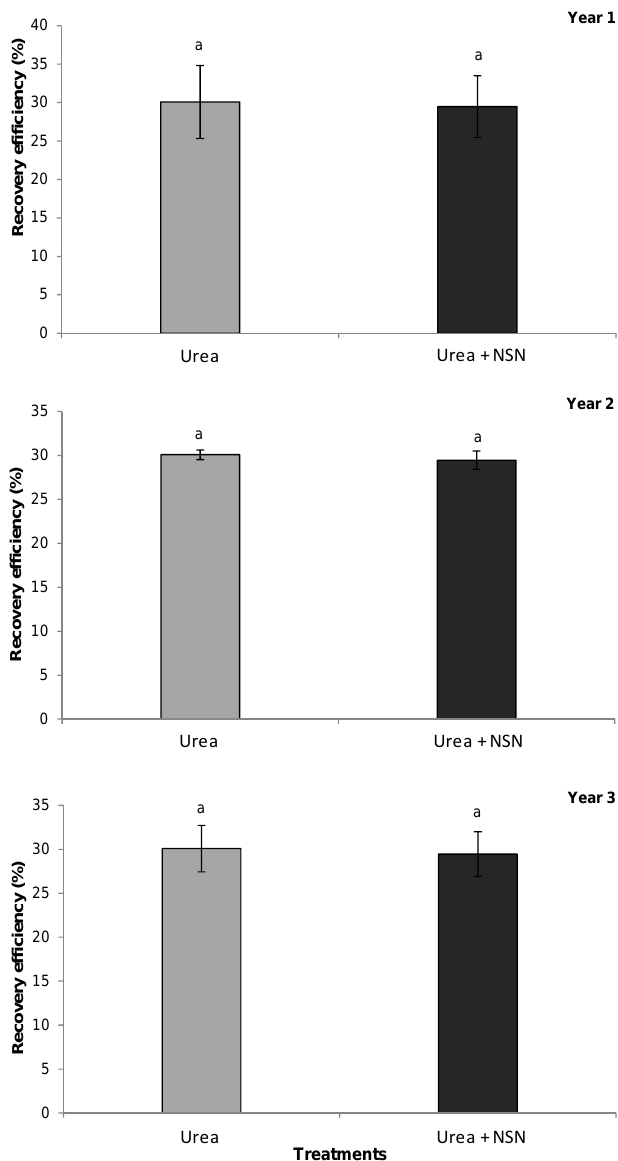
Figure 6. Nitrogen recovery efficiency (RE) affected by urea or urea treated with NSN (urea + NSN) applied broadcast on the surface during three growing seasons to no-till corn. Means followed by the same letter are not significantly different from each other based on the LSD test (0.05). Vertical bars indicate standard error. NSN, maleic itaconic acid.